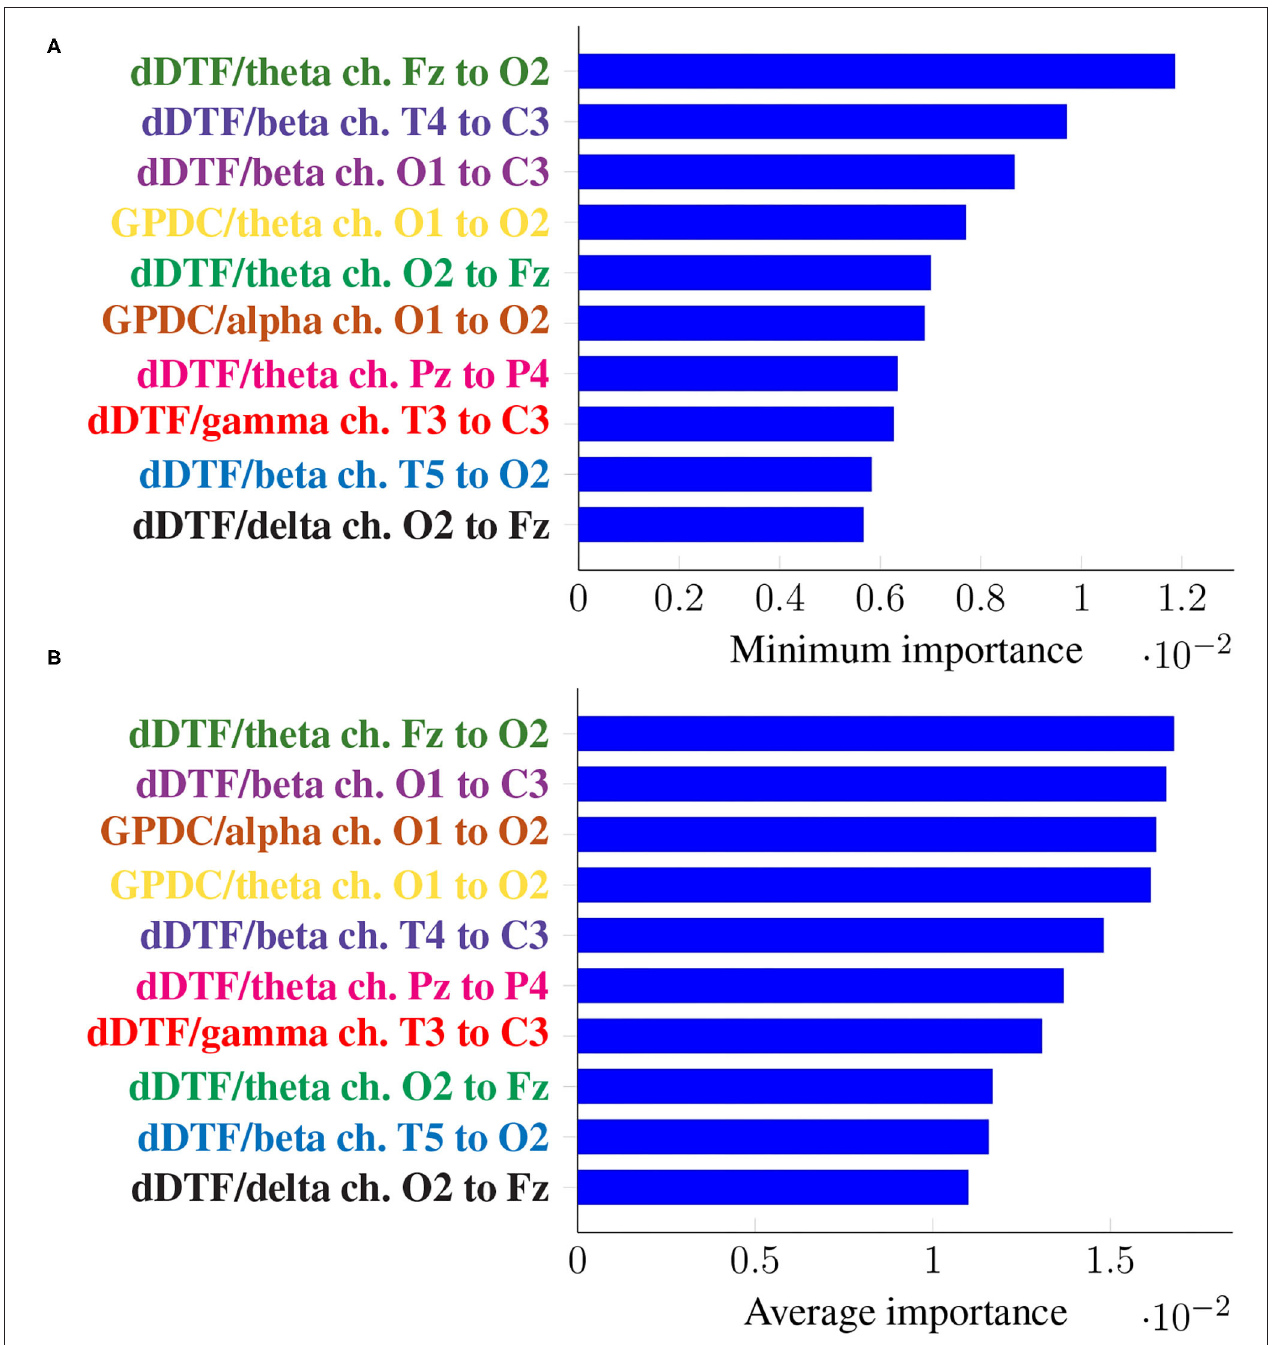
FIGURE 5 | Feature importance summarized across folds using the minimum (A) and the mean (B) for subject-unaware data partitioning strategy. Every feature is determined by the metric (left of “/”), the frequency band (right of “/”), and the EEG channels involved (notice the order is important).